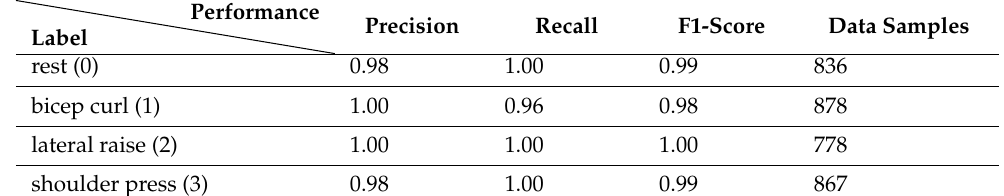
Table 5. Evaluation metrics table of deep learning model.